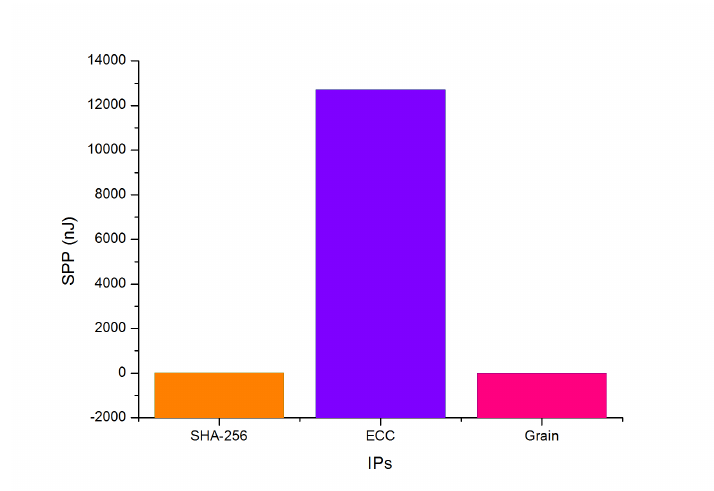
Figure 12. FPGA Implementation SPP of the proposed